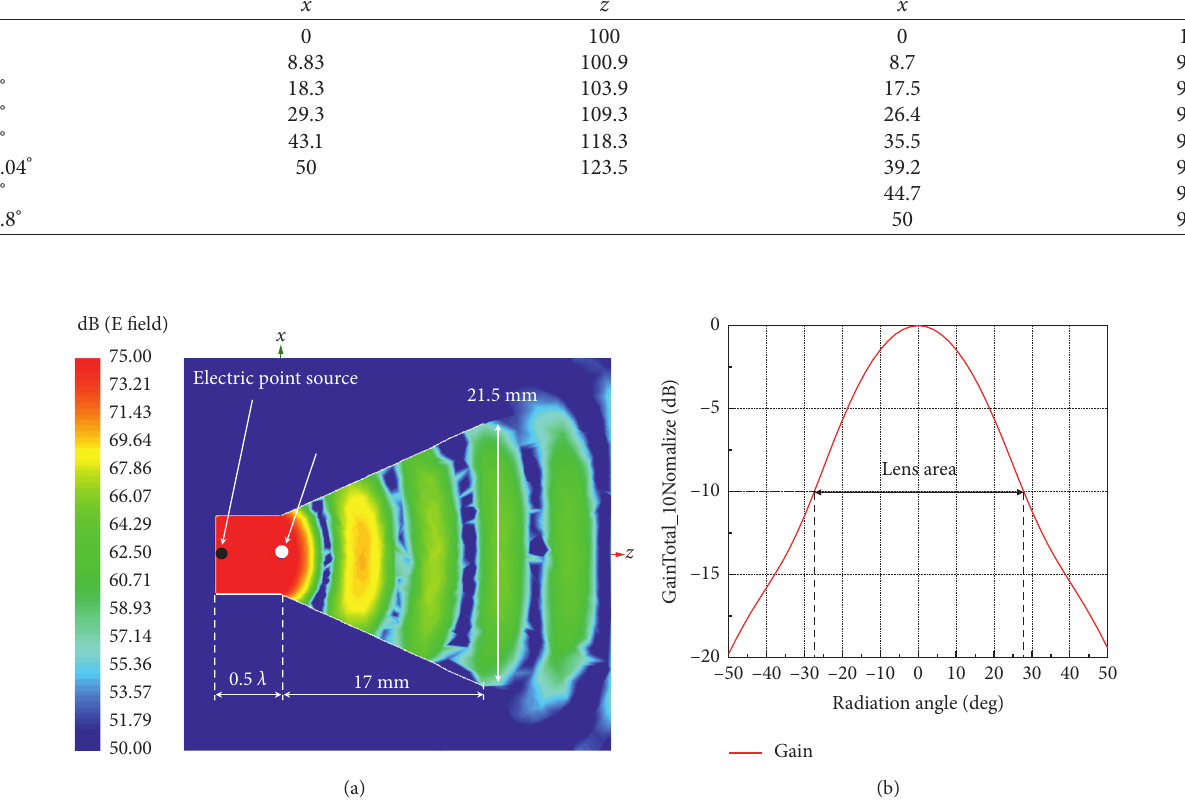
Figure 3: Parameters and the radiation pattern of the conical horn. (a) Conical horn antenna structure, (b) horn radiation patterns.